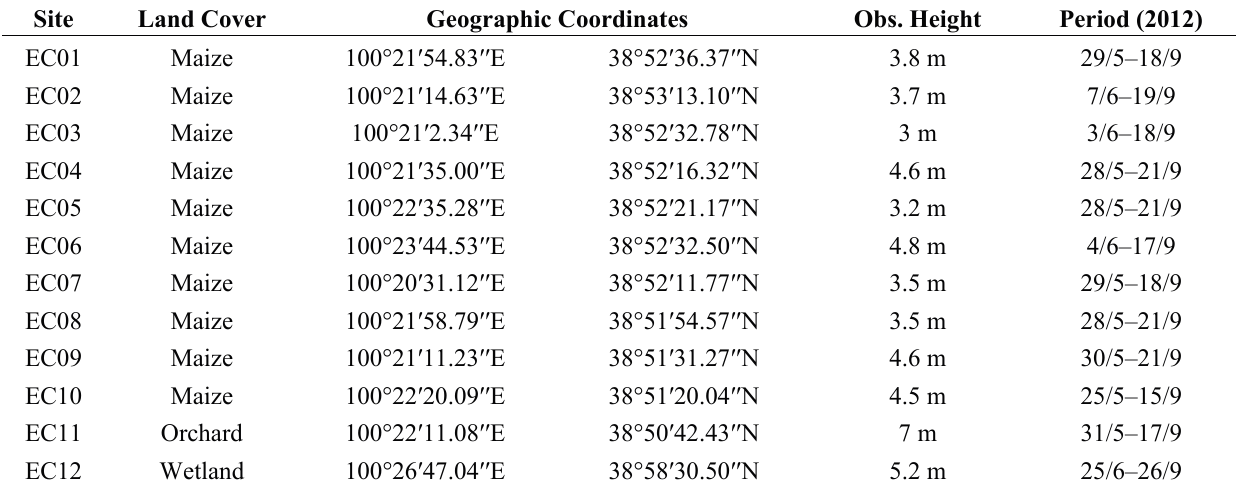
Table 2. Information summary for the studied eddy covariance (EC) sites.